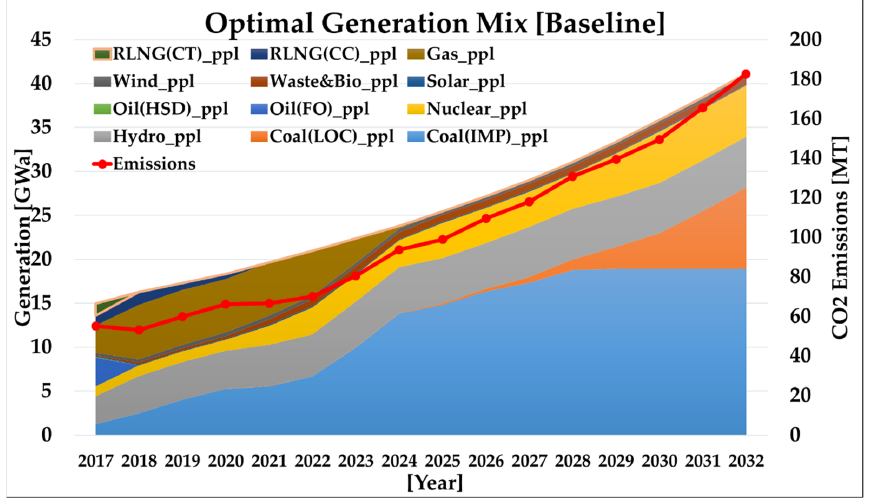
Figure 12. Optimal generation mix along with resulting emissions for the baseline scenario.